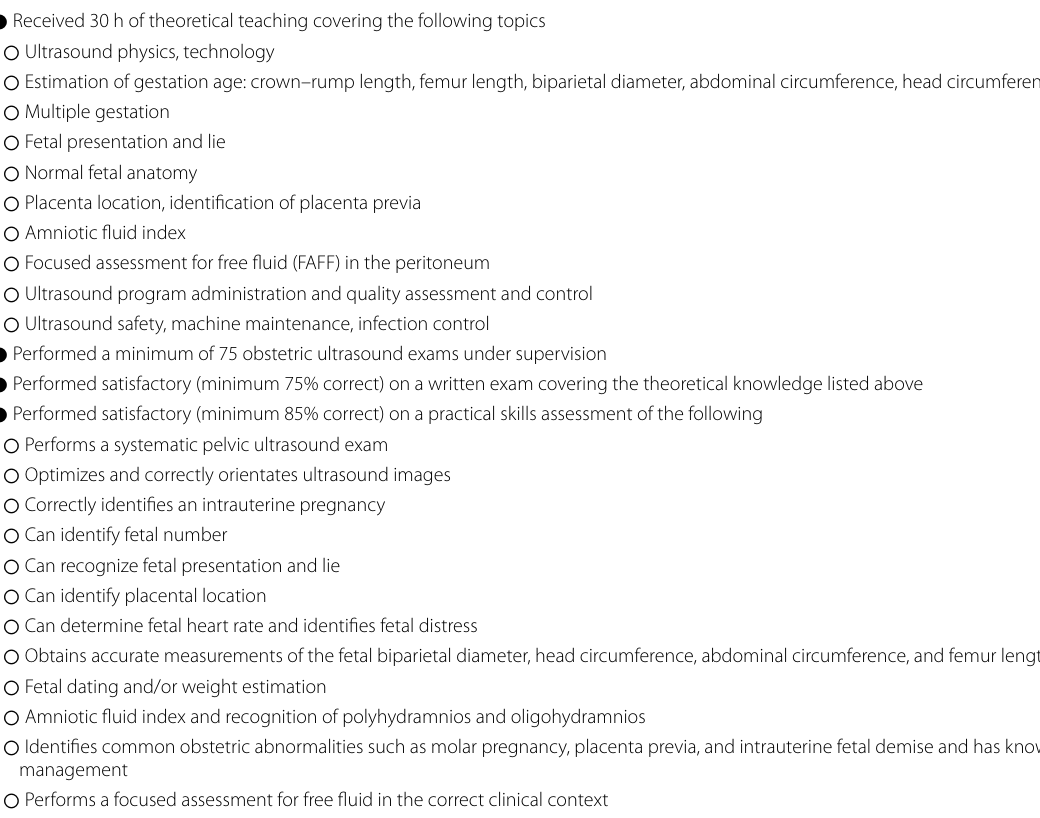
Table 1 Training requirements for PURE pregnancy screening and obstetrics ultrasound course completion ● Received 30 h of theoretical teaching covering the following